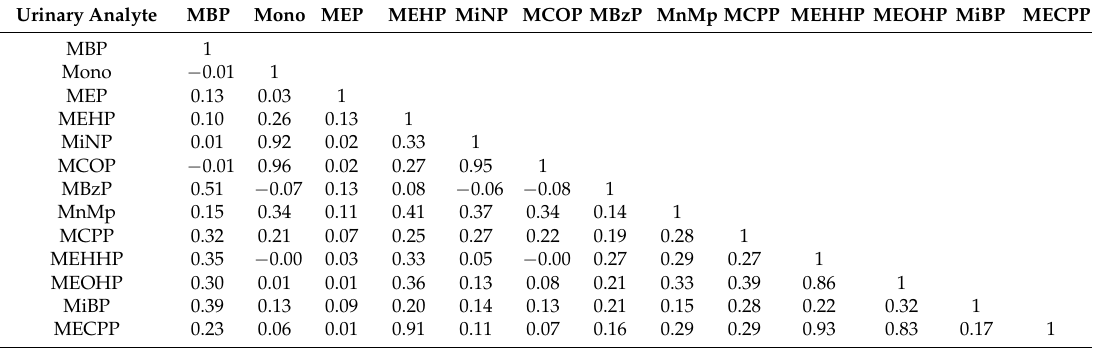
Table 1. Correlation matrix among phthalate